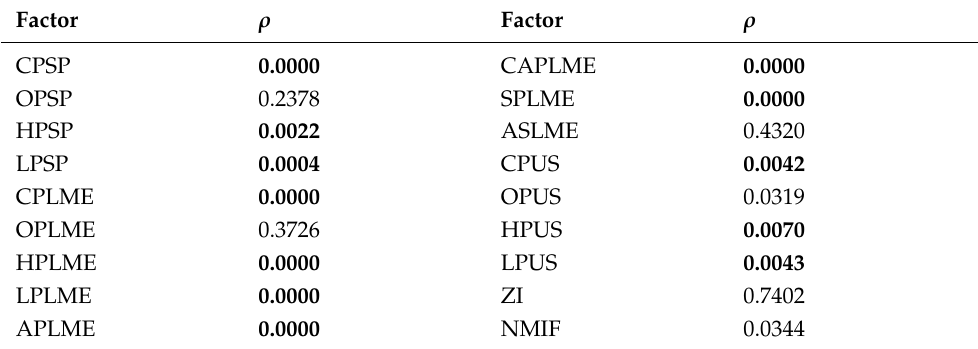
Table 2. The results of the Granger causality